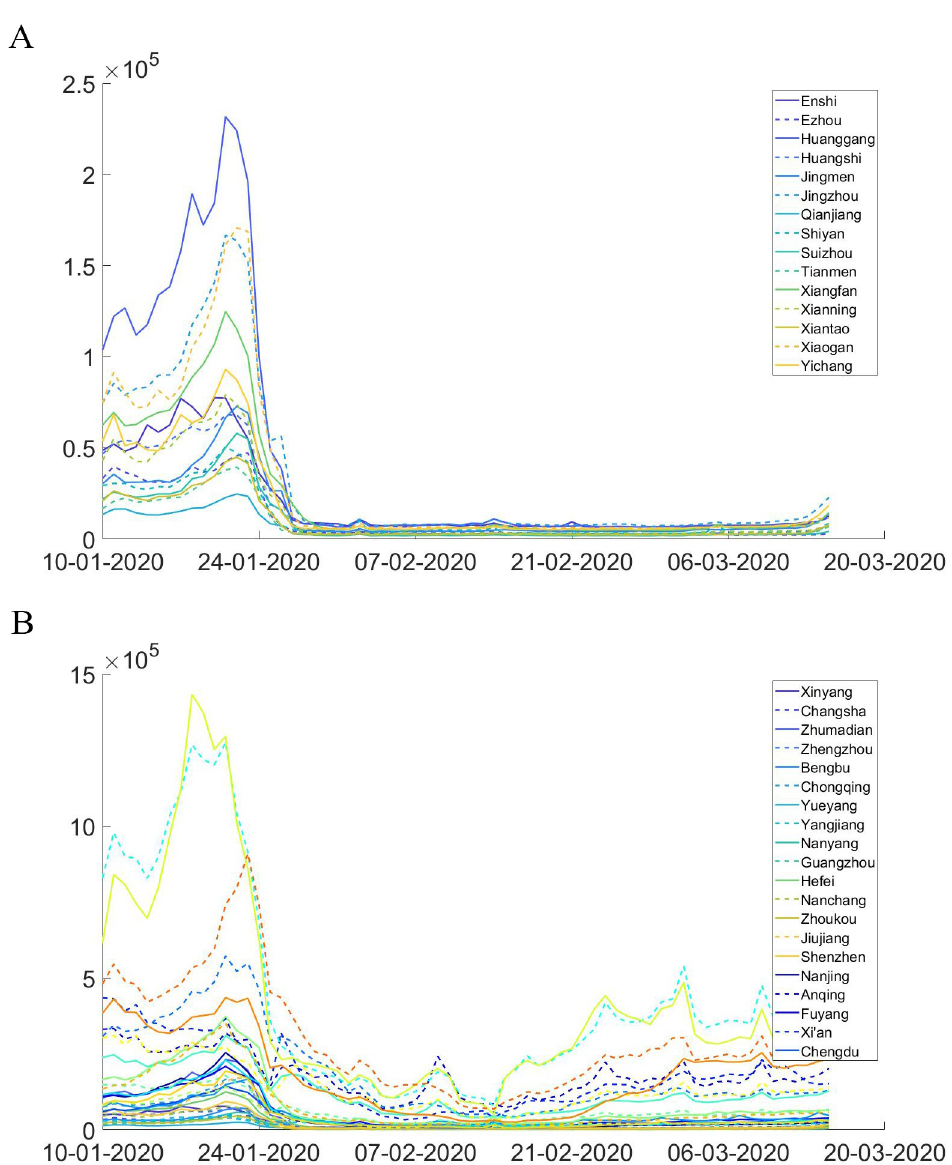
Fig 5. Inter-city population flows. These graphs plot the size of daily aggregate population inflow into cities in Hubei (a) and selected cities out of Hubei (b).